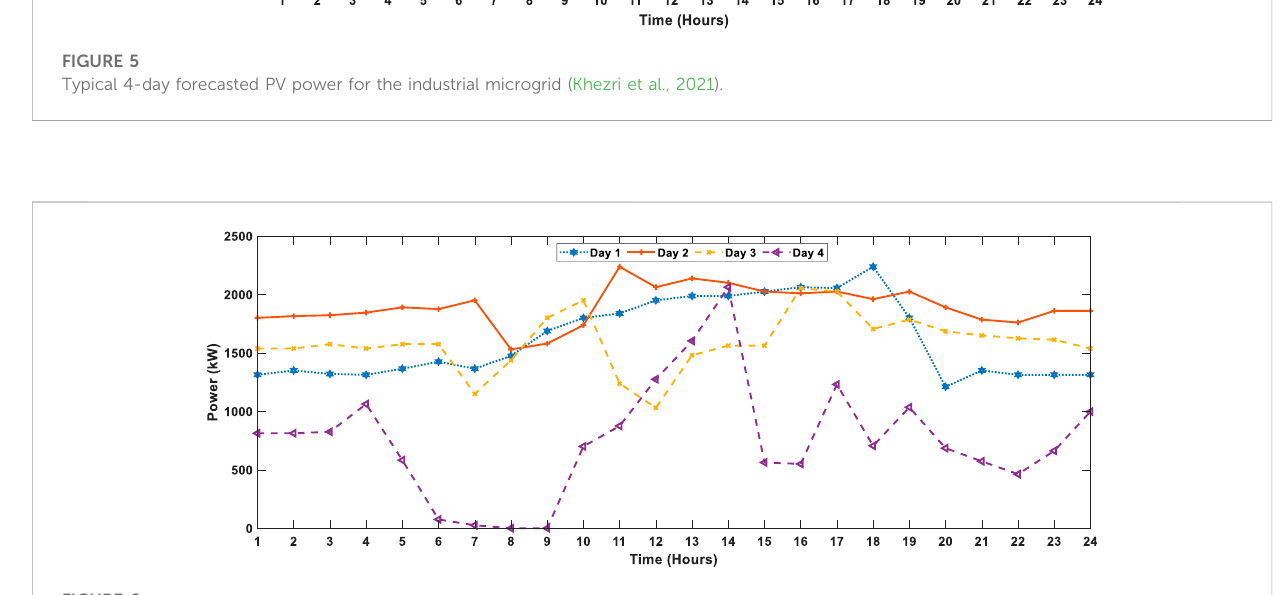
FIGURE 6 Typical 4-day forecasted wind power for the industrial microgrid (Khezri et al., 2021).